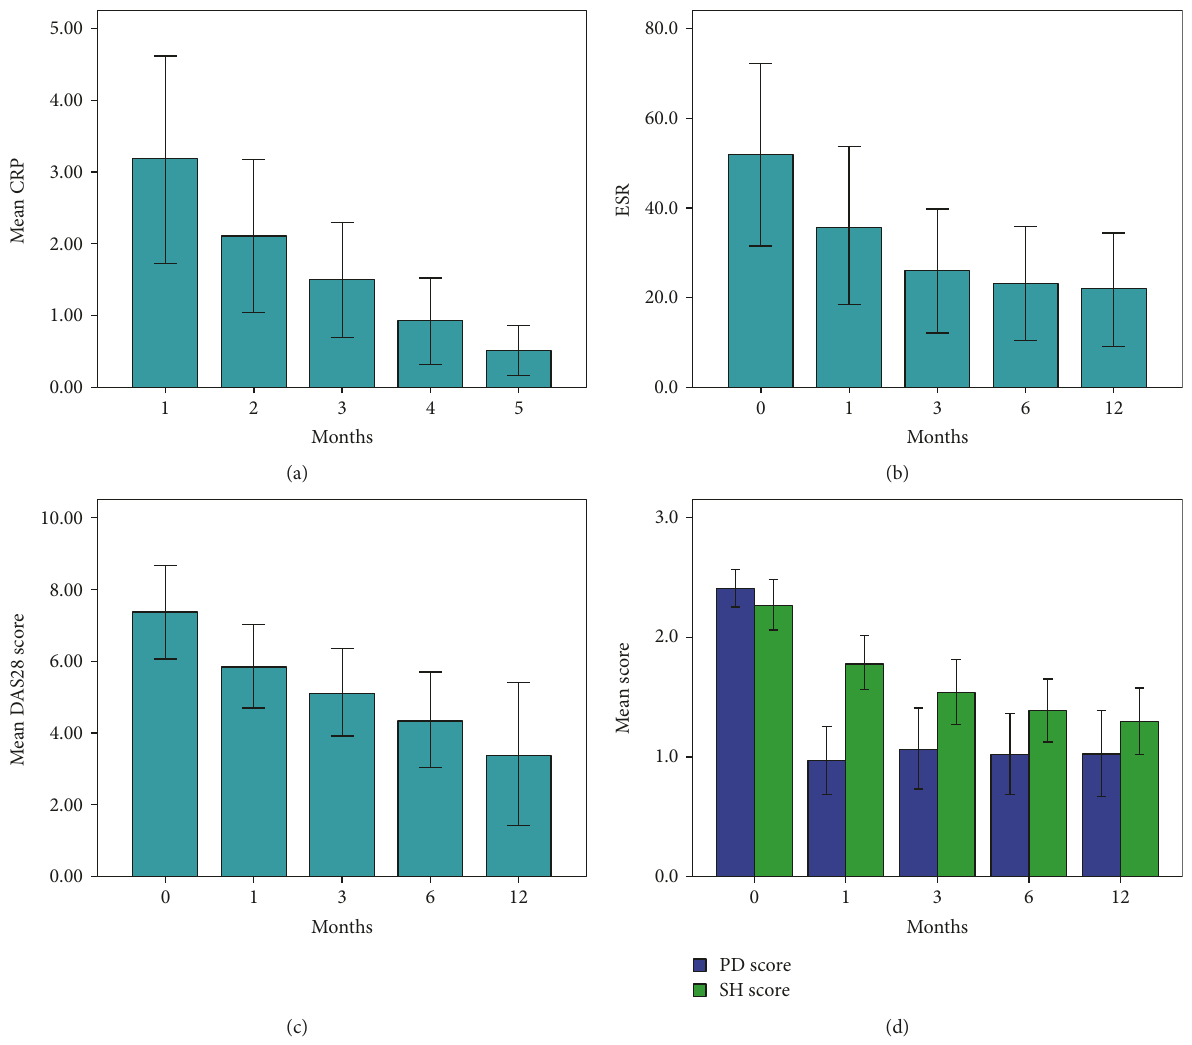
Figure 2: After adalimumab therapy, ESR, CRP, and DAS28 decreased gradually. The PDUS score decreased dramatically within the fi rst month (baseline versus 1 month, p = 0 001 by Wilcoxon test) and remained low score (1 month versus 3 months versus 6 months versus 12 months, p = 0 379 by repeated measures ANOVA). The GS synovitis decreased less dramatically than PDUS and continued until the 12th month. Using repeated measures ANOVA, the slope was di ff erent between the gray scale and power Doppler e ff ect ( p = 0 008